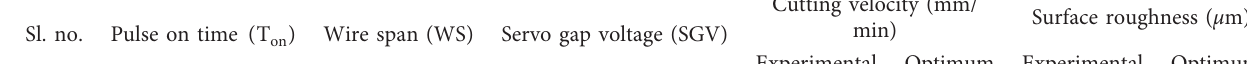
Table 5: Genetic algorithm optimization parameters.